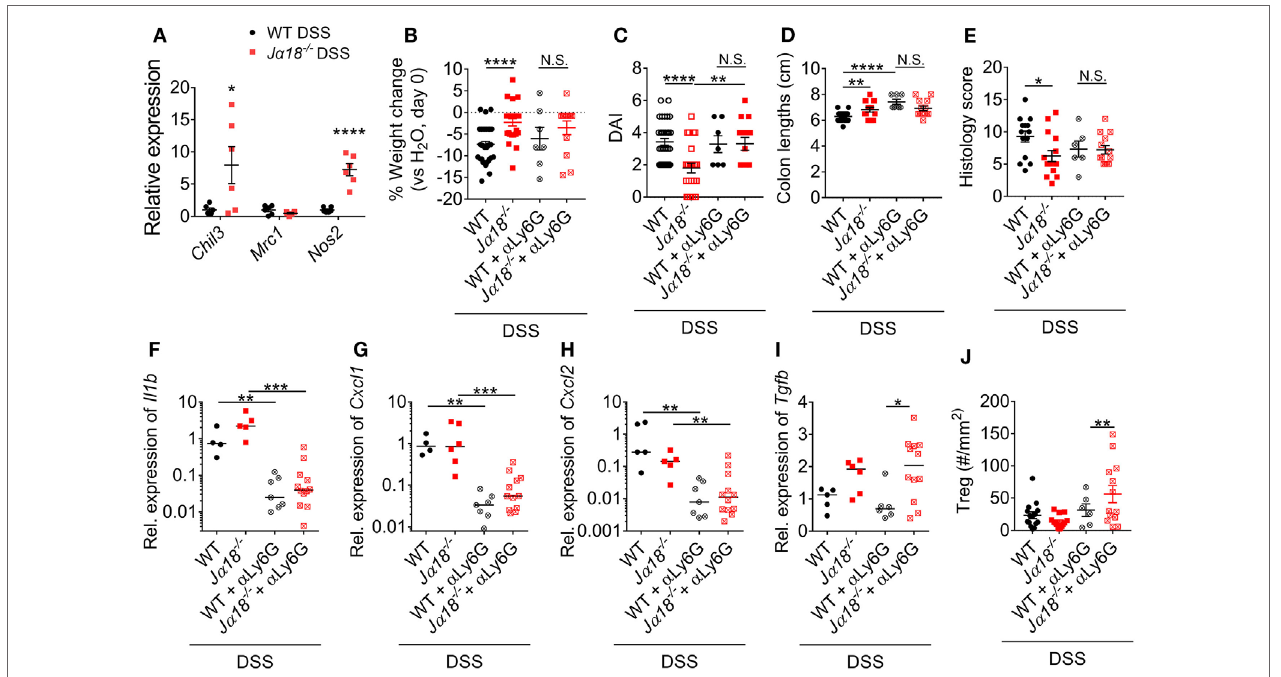
FigUre 6 | Neutrophil phenotype and function in wild type (WT) and J α 18 − / − mice. (a) Gene expression of isolated neutrophils from the colon of 2% dextran sodium sulfate (DSS)-treated WT and J α 18 − / − mice was analyzed by qPCR and normalized to that of WT DSS mice. (B) Weight change, (c) disease activity index (DAI), (D) colon lengths, and (e) histology scoring of WT and J α 18 − / − mice with or without depletion of neutrophils were assessed at day 7 of our DSS model. (F–i) Colon from these mice was collected, and gene expression analyzed and normalized to WT DSS. (J) The number of Tregs in the colon was enumerated by immunofluorescence. n ≥ 4. For (a–e,J) , data represent mean ± SEM, and Student’s t -test was performed. For (F–i) , lines represent median, and Mann–Whitney U -test was performed. Significance is represented by * p < 0.05, ** p < 0.01, *** p < 0.001, and **** p < 0.0001. N.S. denotes not significant. WT and J α 18 − / − mice DSS data were previously presented in Figure 3 , normalized to WT H 2 O. Data of neutrophil depletion were obtained from two independent